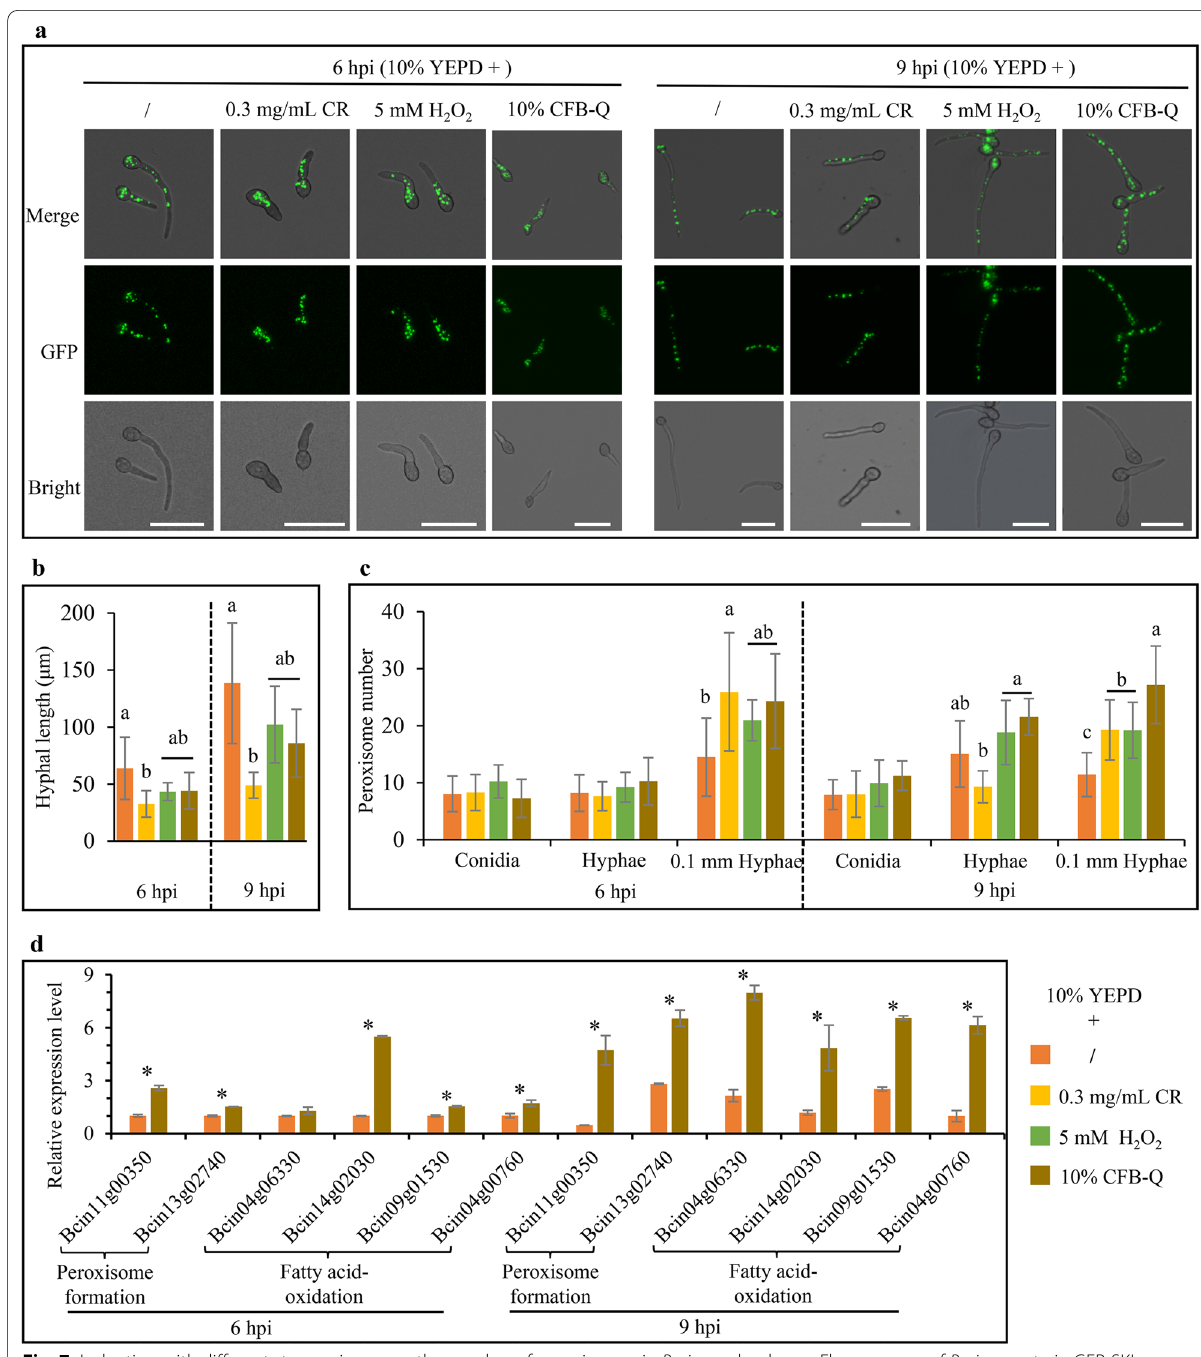
Fig. 7 Induction with different stresses increases the number of peroxisomes in B. cinerea hyphae. a Fluorescence of B. cinerea strain GFP-SKL after incubation in 10% YEPD medium containing 0.3 mg/mL CR, 5 mM H 2 O 2 , or 10% cell-free fermentation broth of B. velezensis QSE-21 (CFB-Q). Bar 50 μm. b , c Column charts showing hyphal length and peroxisome number. The values represent the average values, and the error bars = indicate the standard deviations of 20 hyphae in one experiment. The different letters (a, b, and c) indicate significant differences at the level of P < 0.01. d Relative expression levels of 6 DEGs annotated to the peroxisome pathway via RT-qPCR analysis. BcTubulin was used as an endogenous control, and the sample collected from 10% YEPD medium at 6 hpi was used as a sample control. The values represent the average values, and the error bars indicate the standard deviations of 3 technical replicates of one experiment. *, P <